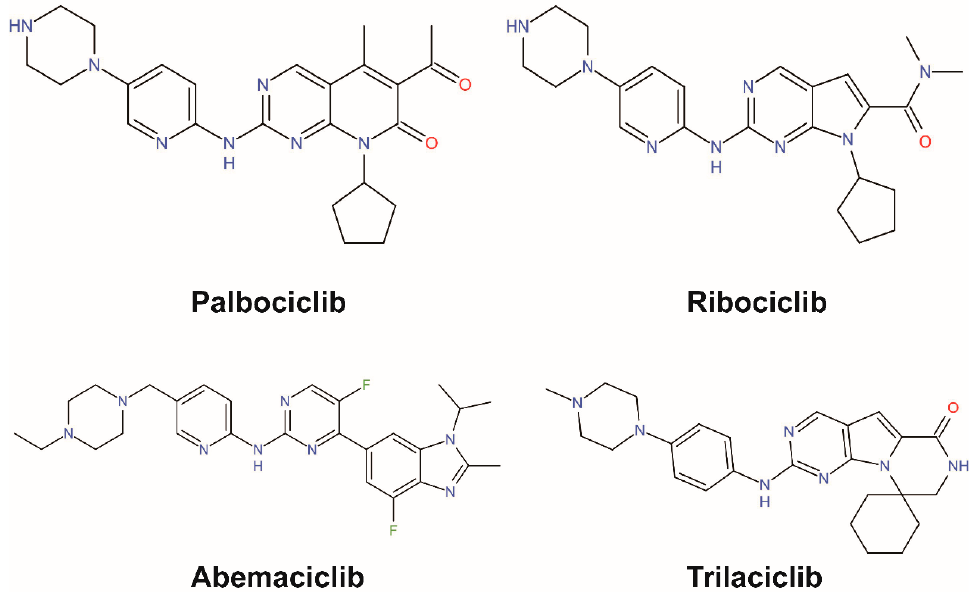
Figure 3. Chemical structures of CDK4/6-specific small molecular inhibitors approved by the FDA. Table 1. Comparison of CDK4/6 inhibitors.